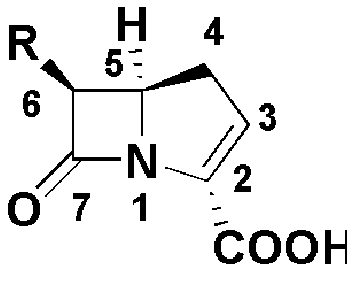
Figure 2. Chemical structure of carbapenems.